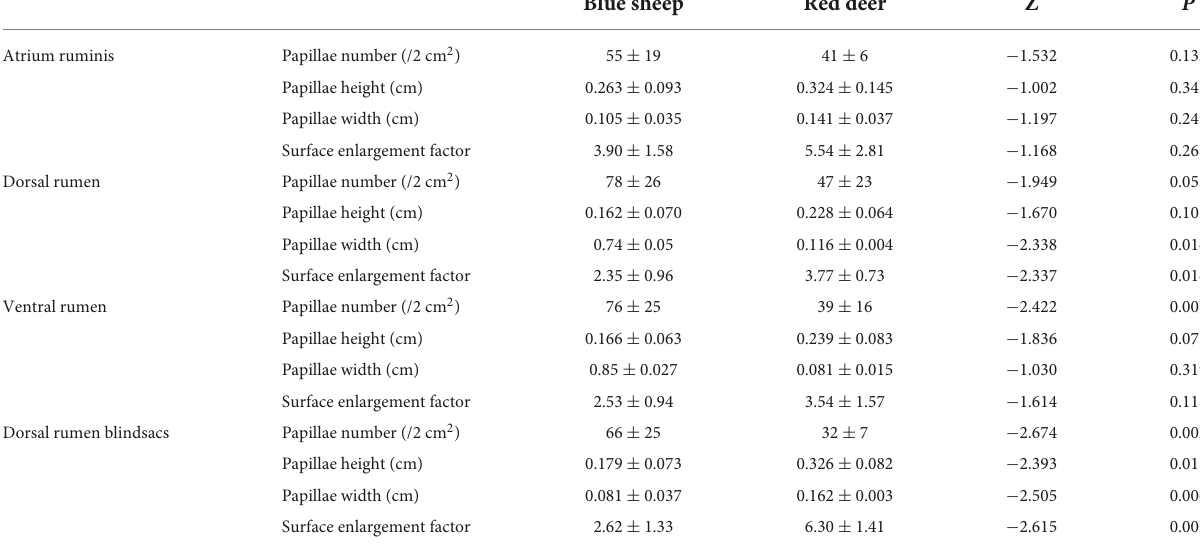
TABLE 1 The mastoid width, height and number, surface enlargement factor of sympatric blue sheep and red deer. Blue sheep Red deer Z